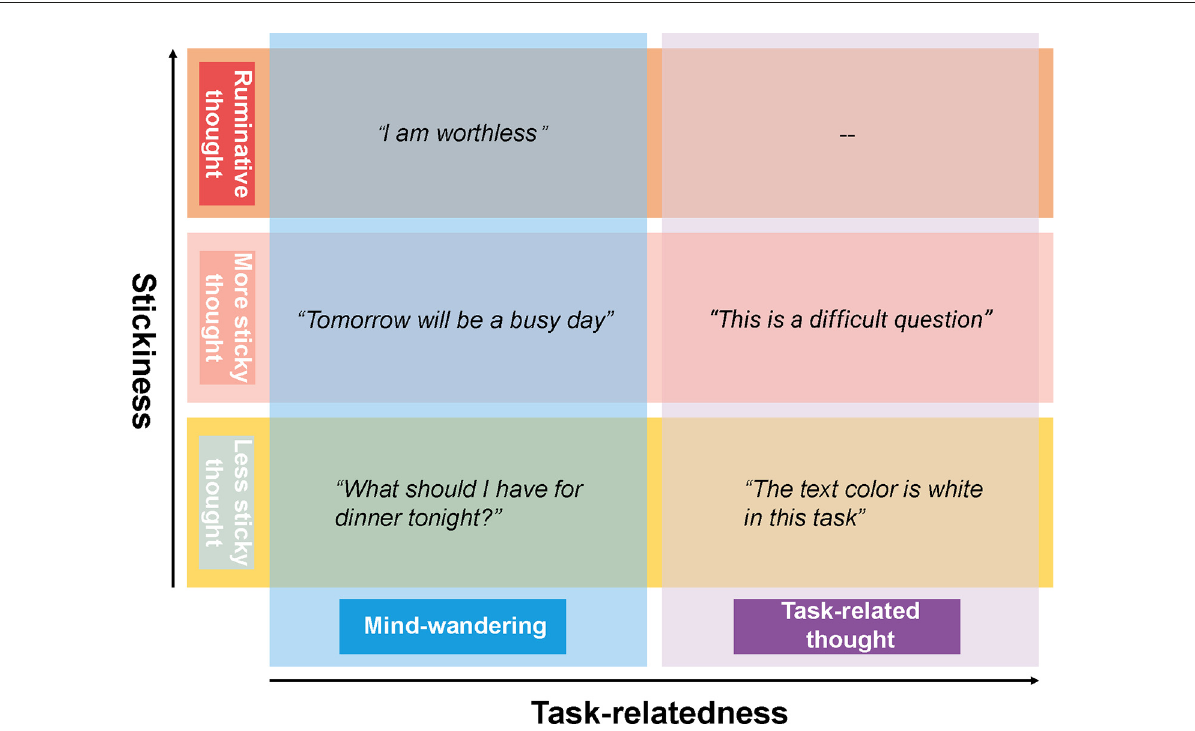
FIGURE1 The framework of spontaneous thoughts and the examples, the horizontal axis shows the task-relatedness dimension of spontaneous thoughts while the vertical axis shows the stickiness